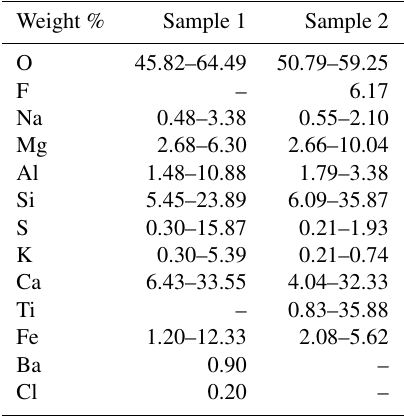
Table A1. Chemical composition of the two dust samples. The num- bers show the minimum/maximum value of the elements found in the